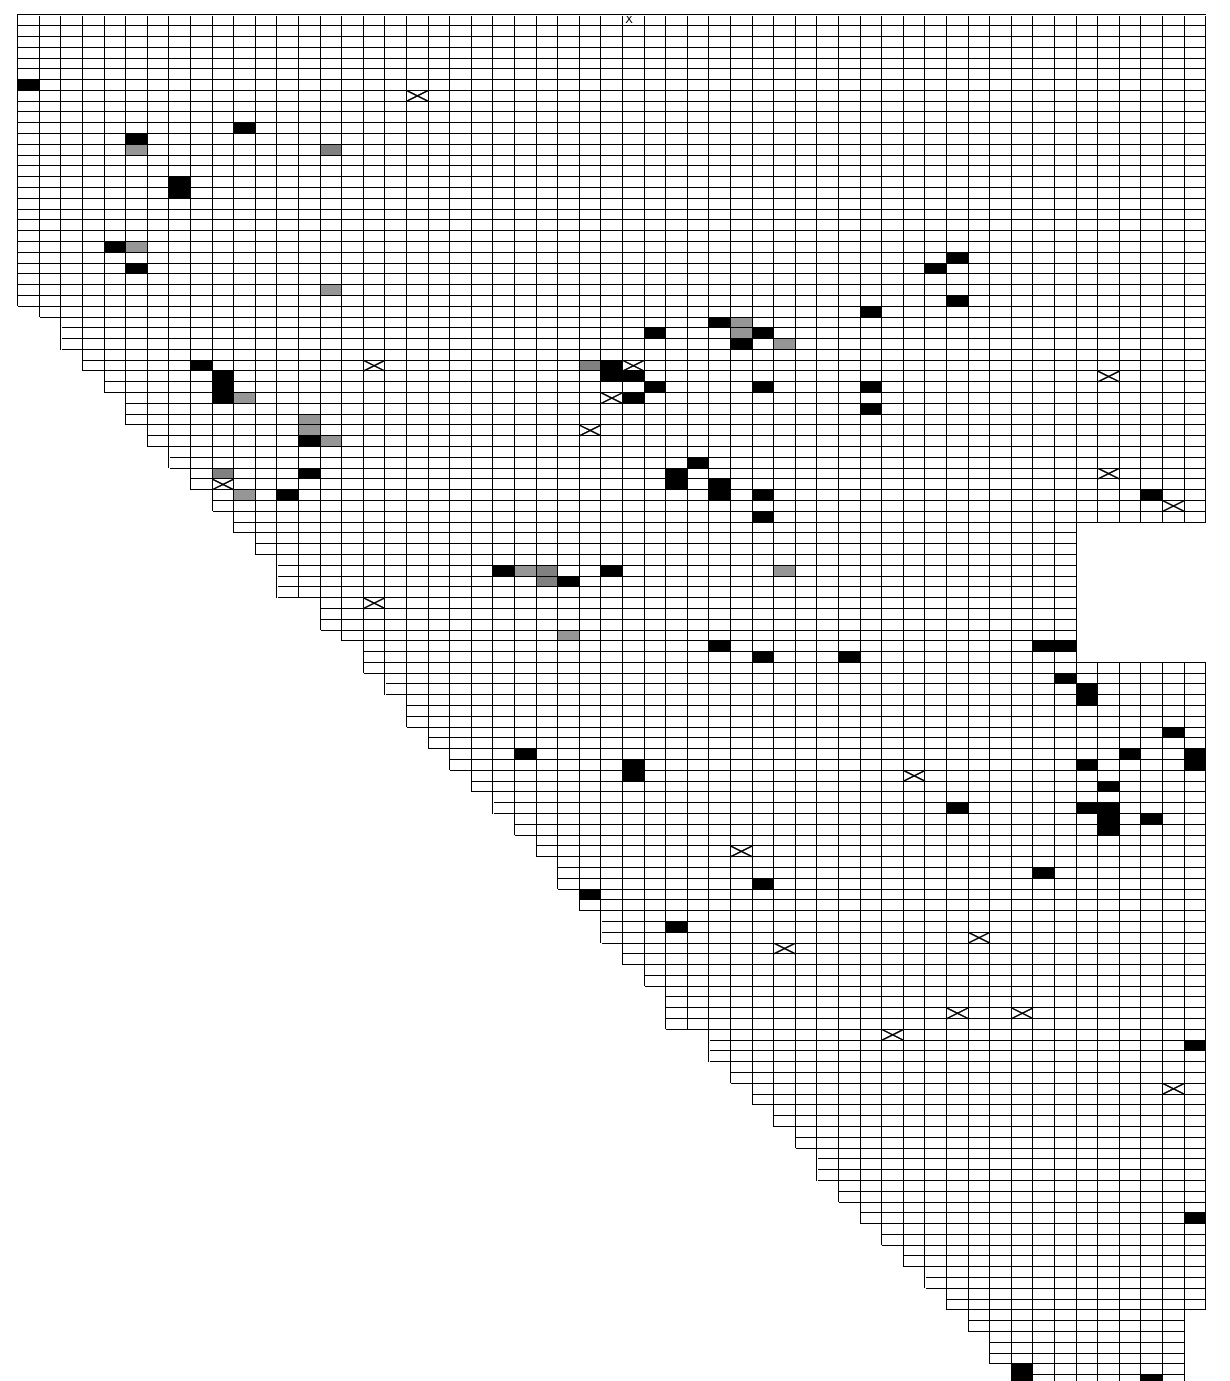
Fig. 1. Map of 7-year-old Shiraz vines (Site 1) express- ing esca foliar symptoms. Grey squares: symptomatic in year 2000; black squares: symptomatic in year 2001; (cid:1) : missing